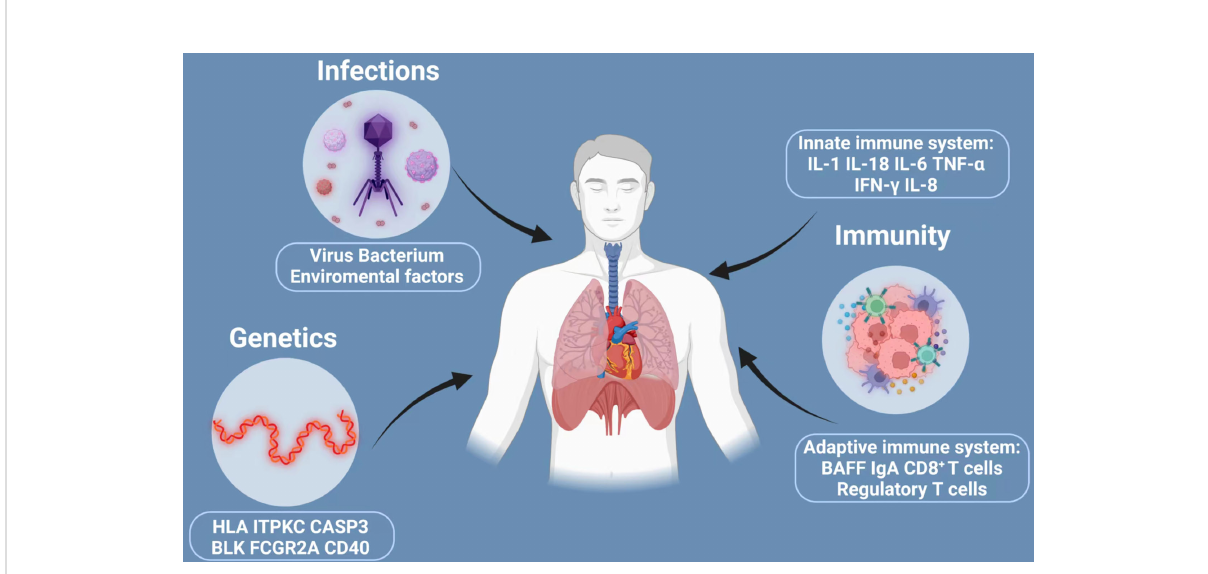
FIGURE 1 Three major factors implicated in the development of Kawasaki disease: infections, genetics and immunity. The development and progression of KD is a concerted effect of multifaceted contributions, mainly including genetic susceptibility, infectious trigger and immunological factors. However, many of the claims are unproved. The current understanding is that KD is triggered in a small population of genetically susceptible children by a ubiquitous infection that trigger in fl ammatory cascades with activation of both the innate and adaptive immune system and fi nally may cause KD. HLA, human leukocyte antigen; ITPKC, inositol 1,4,5-Trisphosphate kinase-C; CASP3, caspase3; BLK, B cell lymphoid kinase; FCGR2A, Fc fragment of IgG receptor IIa; IL-1, interleukin-2; IL-18, interleukin-18; IL-6, interleukin-6; TNF- a , transforming growth factor- a ; IFN- g , interferon- g ; IL-8, interleukin-8; BAFF, B-cell Activating factor of the TNF